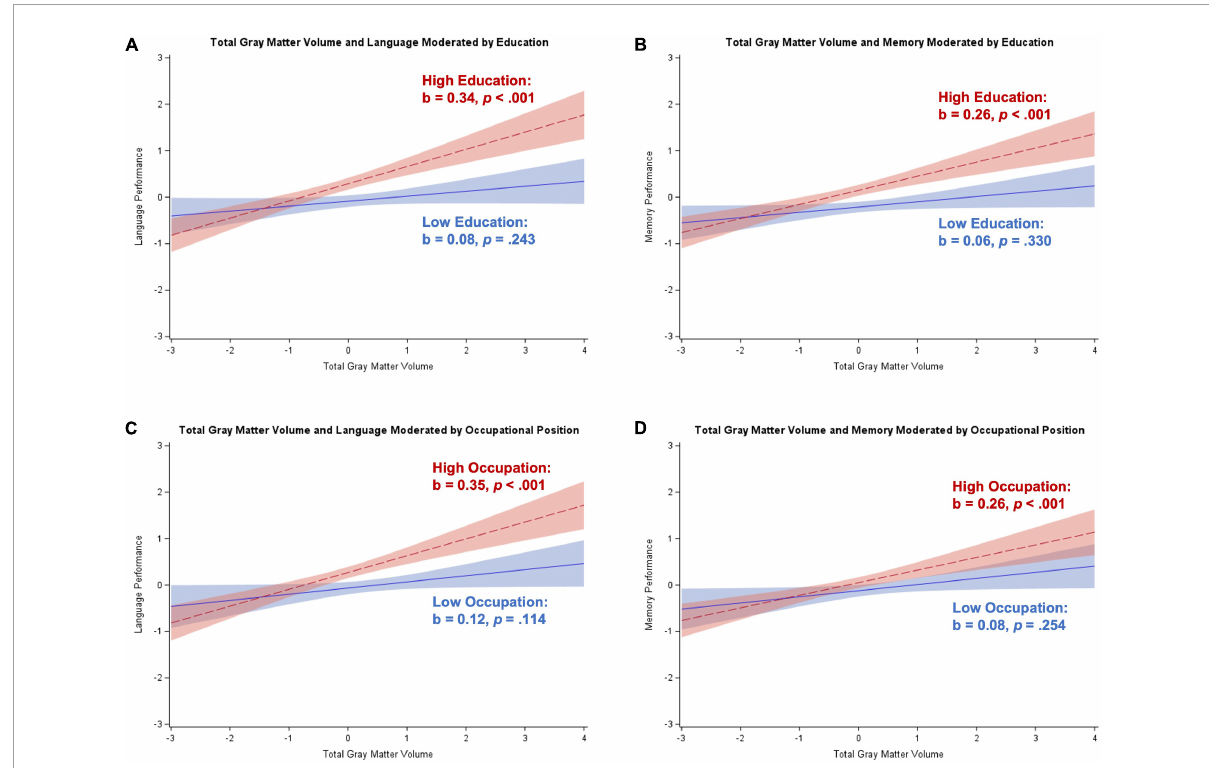
FIGURE5 Plots of significant moderations by education and occupational position of the associations between total gray matter volume and cognition for participants with amnestic mild cognitive impairment. High education or occupational position corresponds to 1 SD above the mean and low education or occupational position corresponds to 1 SD below the mean. The red dotted line represents high education or occupational position, and the blue solid line represents low education or occupational position. Shaded areas represent 95% confidence intervals. Cognition and total gray matter volume were standardized. (A) Significant positive association between total gray matter volume and language for participants with high education; non-significant positive association for low education. (B) Significant positive association between total gray matter volume and memory for participants with high education; non-significant positive association for low education. (C) Significant positive association between total gray matter volume and language for participants with high occupational position; non-significant positive association for low occupational position. (D) Significant positive association between total gray matter volume and memory for participants with high occupational position; non-significant positive association for low occupational